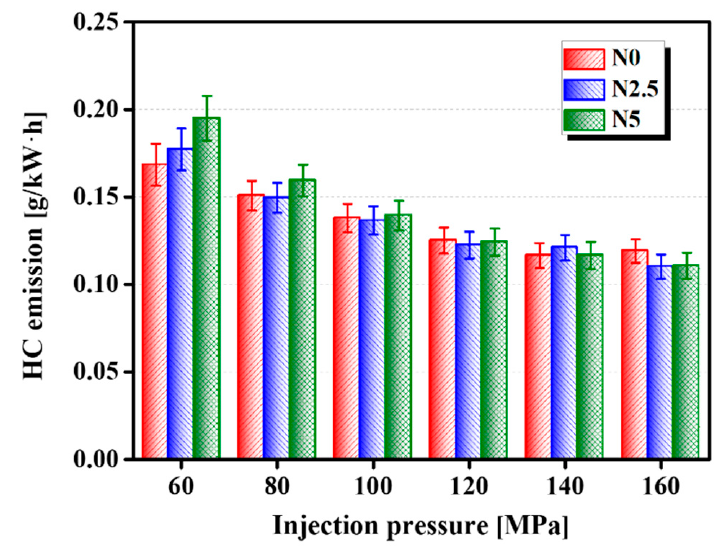
Figure 10. HC emissions of different injection pressures for n -octanol/diesel blends.